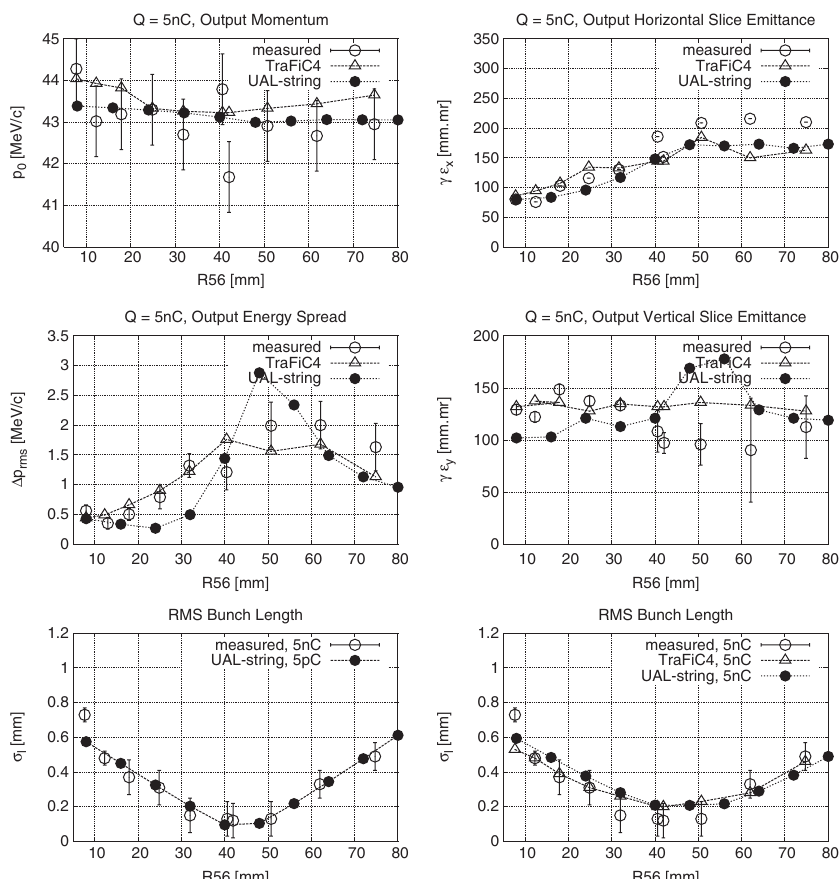
FIG. 3. Q ¼ 5 nC output momentum p , momentum spread (cid:1) p , bunch length (cid:5) l , and (invariant) emittances. In the bottom 0 rms graphs the simulations predict a bunch length dependence on bunch charge Q near the minimum. The deviations visible in these graphs suggest that the system parameters (fit empirically without accounting for this dependence) may not be quite right. The vertical emittance measurements are considered to be ‘‘not very reliable’’ by Braun et al.